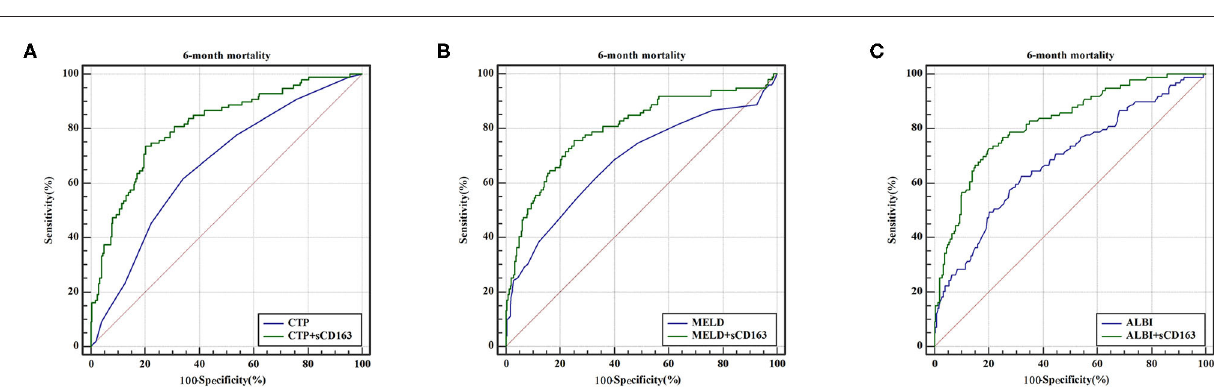
FIGURE 5 | ROC curve analysis and comparison between new scores and original scores for predicting 6-month mortality (A) ROC for CTP and CTP + sCD163; (B) ROC for MELD and MELD + sCD163; (C) ROC for ALBI and ALBI + sCD163.